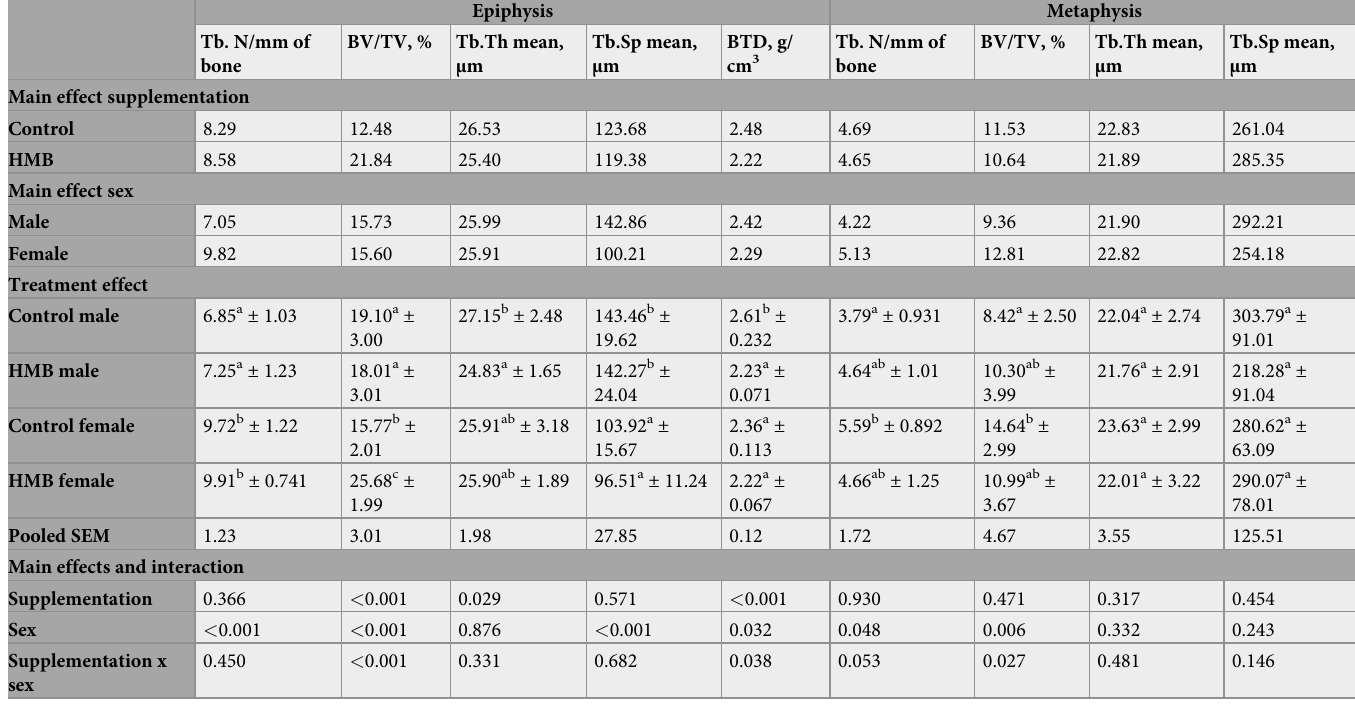
Table 3. The effect of maternal treatment with HMB on humerus epiphysis and metaphysis histomorphology in newborn piglets. Epiphysis Metaphysis Tb. N/mm of